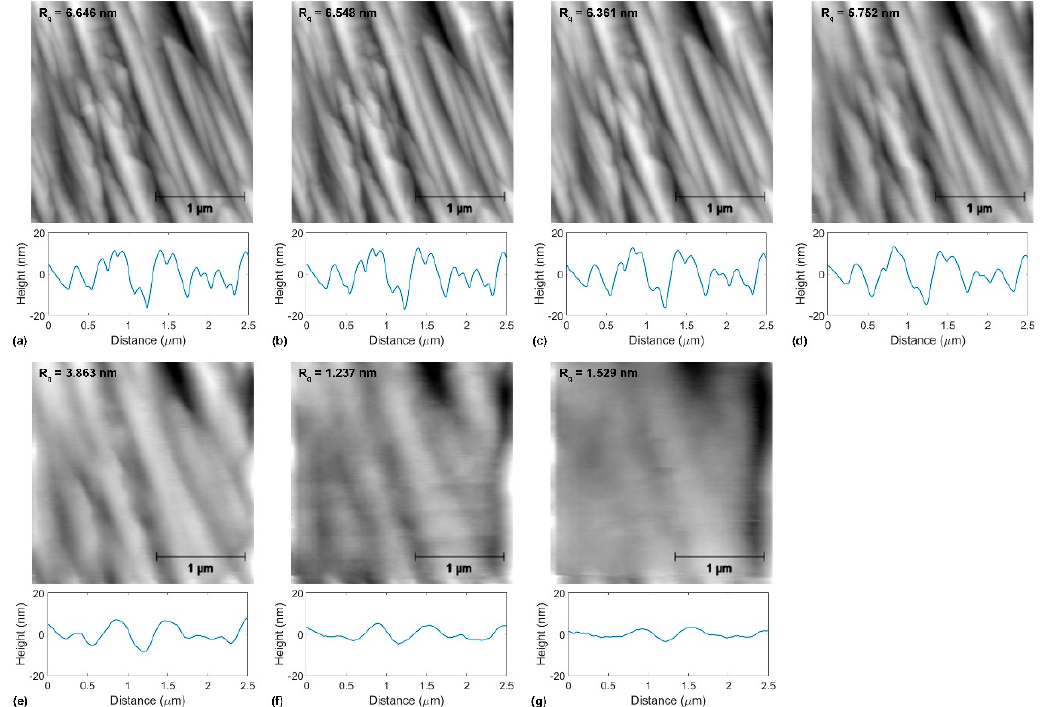
Figure 5. Topographical evolution during tribological tests of graphene-coated copper at the normal force values ( a ) F n = 153 nN, ( b ) F n = 616 nN, ( c ) F n = 1232 nN, ( d ) F n = 2310 nN, ( e ) F n = 3850 nN, ( f ) F n = 5390 nN, and ( g ) F n = 6930 nN. In ( a – g ), the AFM topographical images at the normal force values indicated above, the corresponding roughness parameter R q -values, and representative line scans are presented.